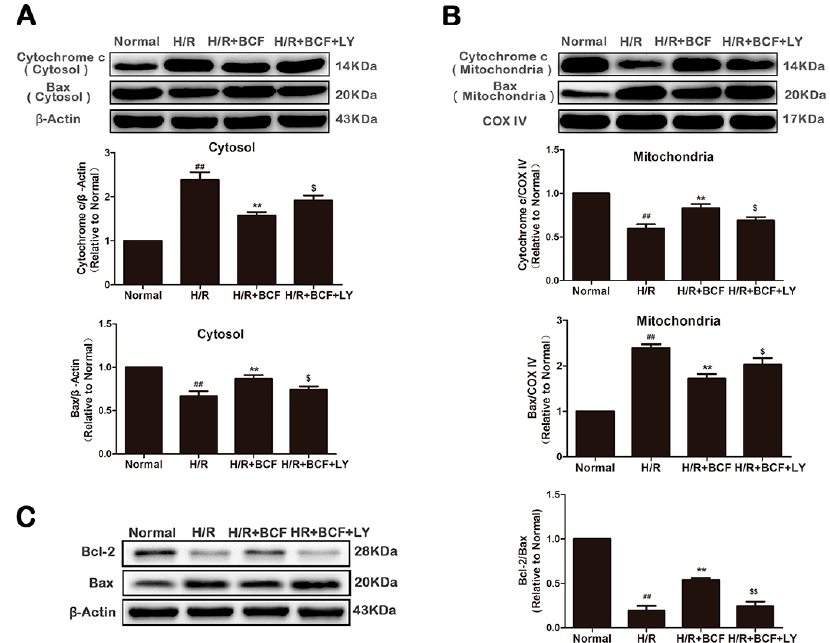
Figure 5. Effects of BCF pretreatment on Bax translocation, release of cytochrome c and the ratio of Bcl-2 to Bax in H/R-treated H9c2 cells. ( A ) The expression of cytochrome c and Bax in the cytosolic fraction was measured by western blotting. β -Actin expression was examined as the protein loading control; ( B ) The expression of cytochrome c and Bax in the mitochondrial fraction was detected by western blotting. COX IV expression was examined as the protein loading control; ( C ) The expression of Bcl-2 and Bax were tested by western blotting. β -Actin as a loading control. Values were represented as mean ± SD ( n = 6, each group). ## p < 0.01 vs. normal; ** p < 0.01 vs. H/R-treated cells;